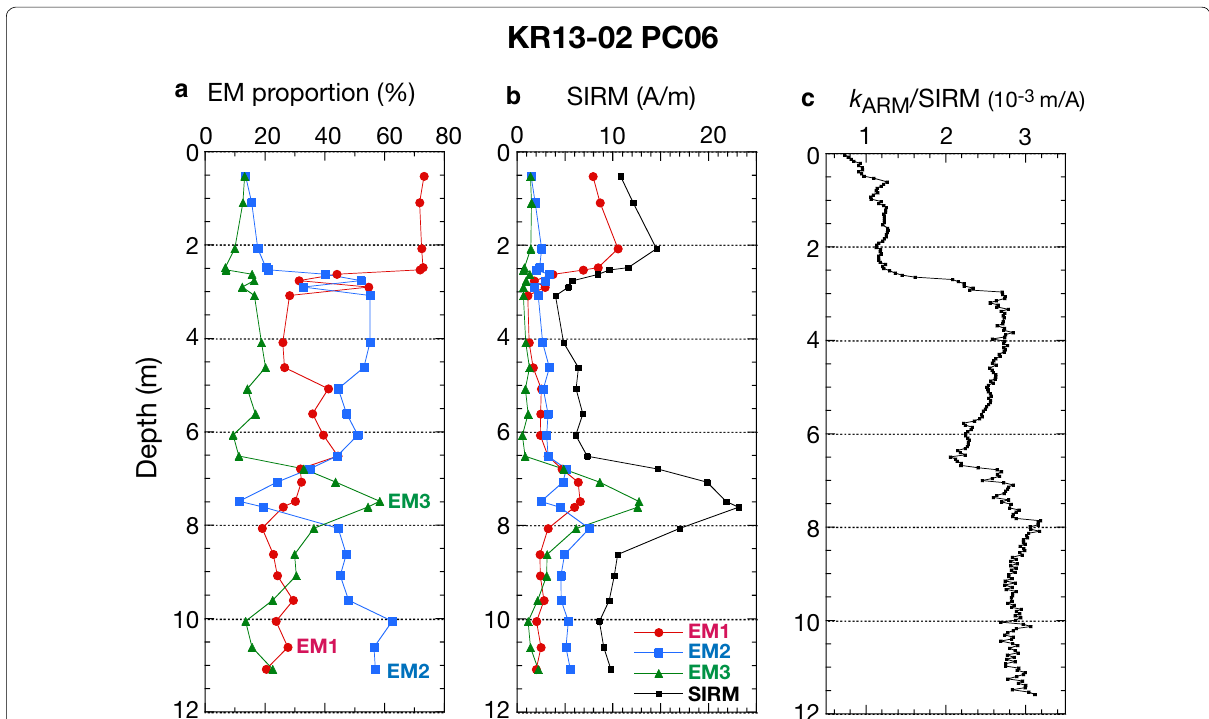
Fig. 5 Downcore variations of FORC-PCA endmembers (EMs) and k ARM /SIRM for core KR13-02 PC06. a The proportion of EM1 (red), EM2 (blue), and EM3 (green). b SIRM (black) and the contribution to SIRM of individual EMs calculated from the respective proportions. c Variations of k ARM /SIRM. Note the synchronous changes of EMs and k ARM /SIRM at ~ 2.7 m, and an EM3 increase between ~ 6.7 and 8.2